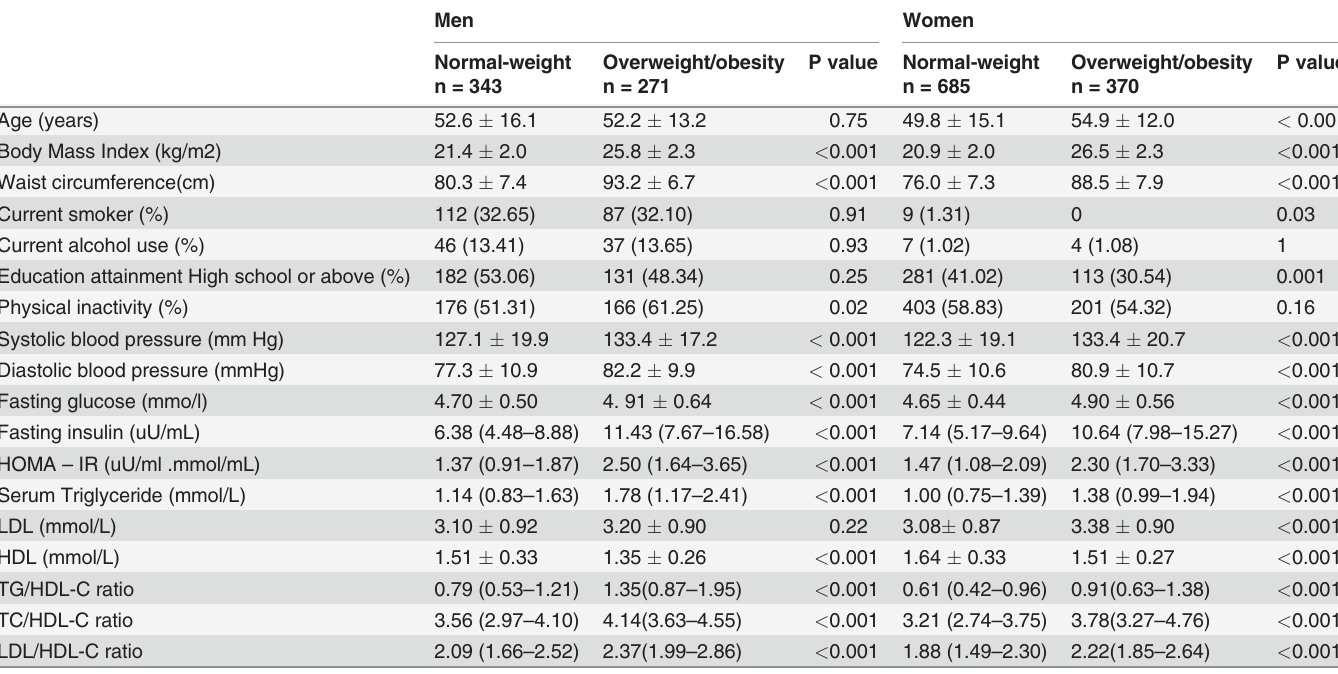
Table 1. Characteristics a of men and women by different BMI